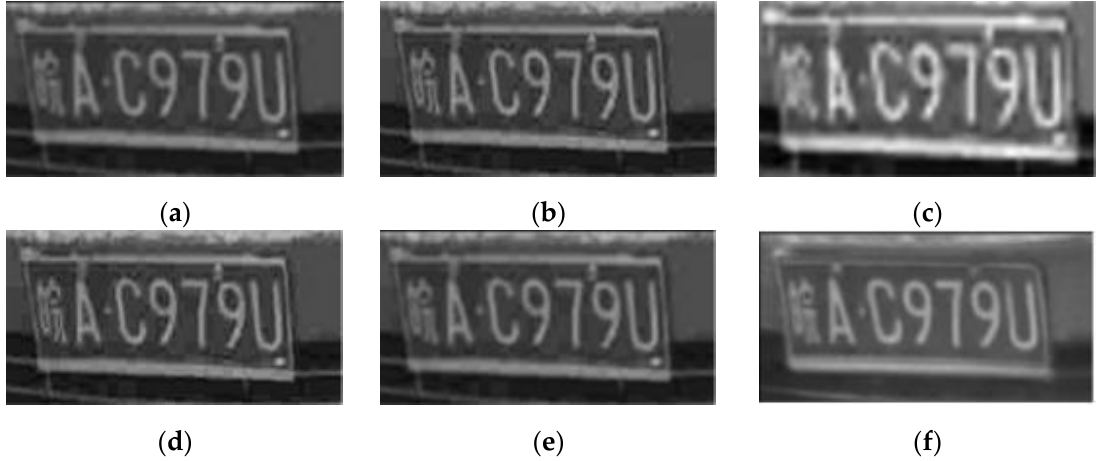
Figure 6. ( a ) Ground Truth ( b ) Bicubic; ( c ) SRCNN; ( d ) ESPCN; ( e ) SRGAN; ( f ) Our Algorithm.